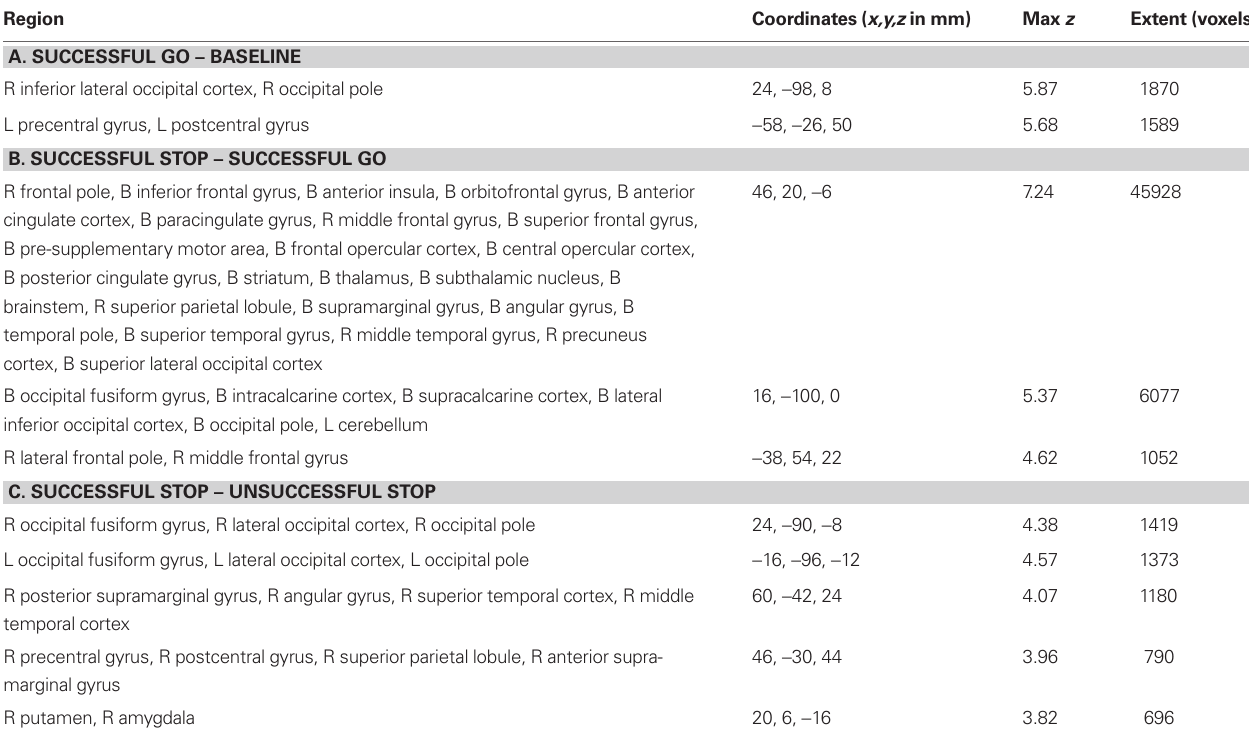
Table 2 | Clusters associated with (A) successful going – baseline, (B) successful stopping – successful going, and (C) successful stopping – unsuccessful